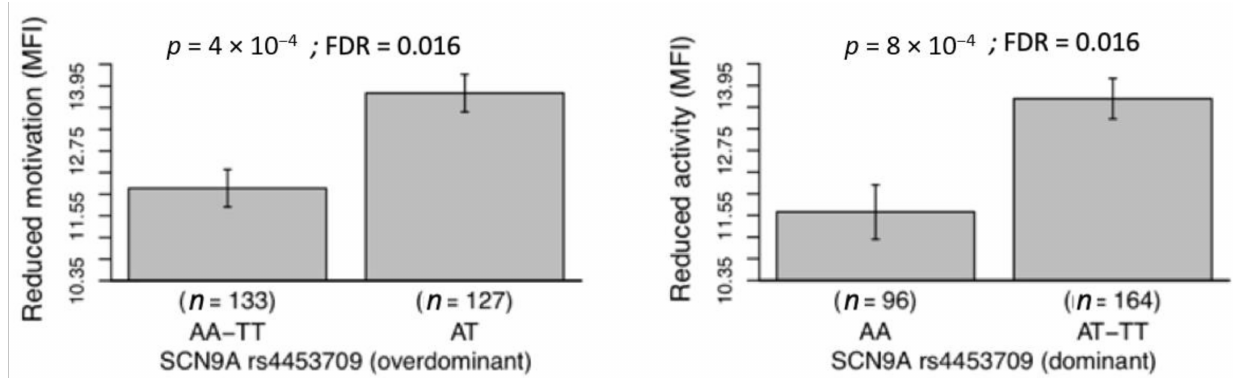
Figure 1. Individual associations of the genotype of the rs4453709 polymorphism ( SCN9A gene) with dimensions of fatigue; i.e., reduced motivation (left panel) and reduced activity (right panel). Note . SCN9A , sodium voltage-gated channel alpha subunit 9 gene; MFI, multidimensional fatigue inventory (MFI, scores range 0–20). According to the p - and false discovery rate (FDR) values, all these associations of genotype and fatigue were significant.